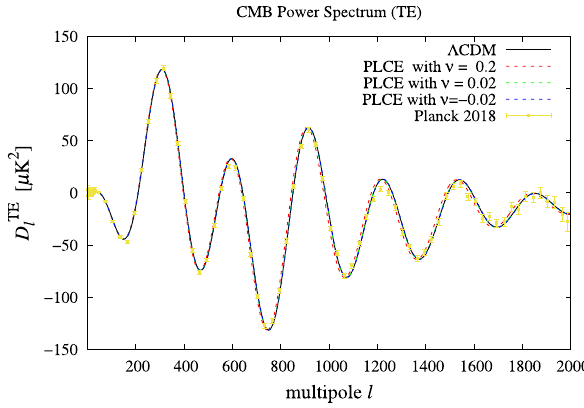
results in PLCE and (cid:2) CDM in Fig. 5, we notice that those of PLCE are closer to the Planck 2018 data, comparing to that in (cid:2)